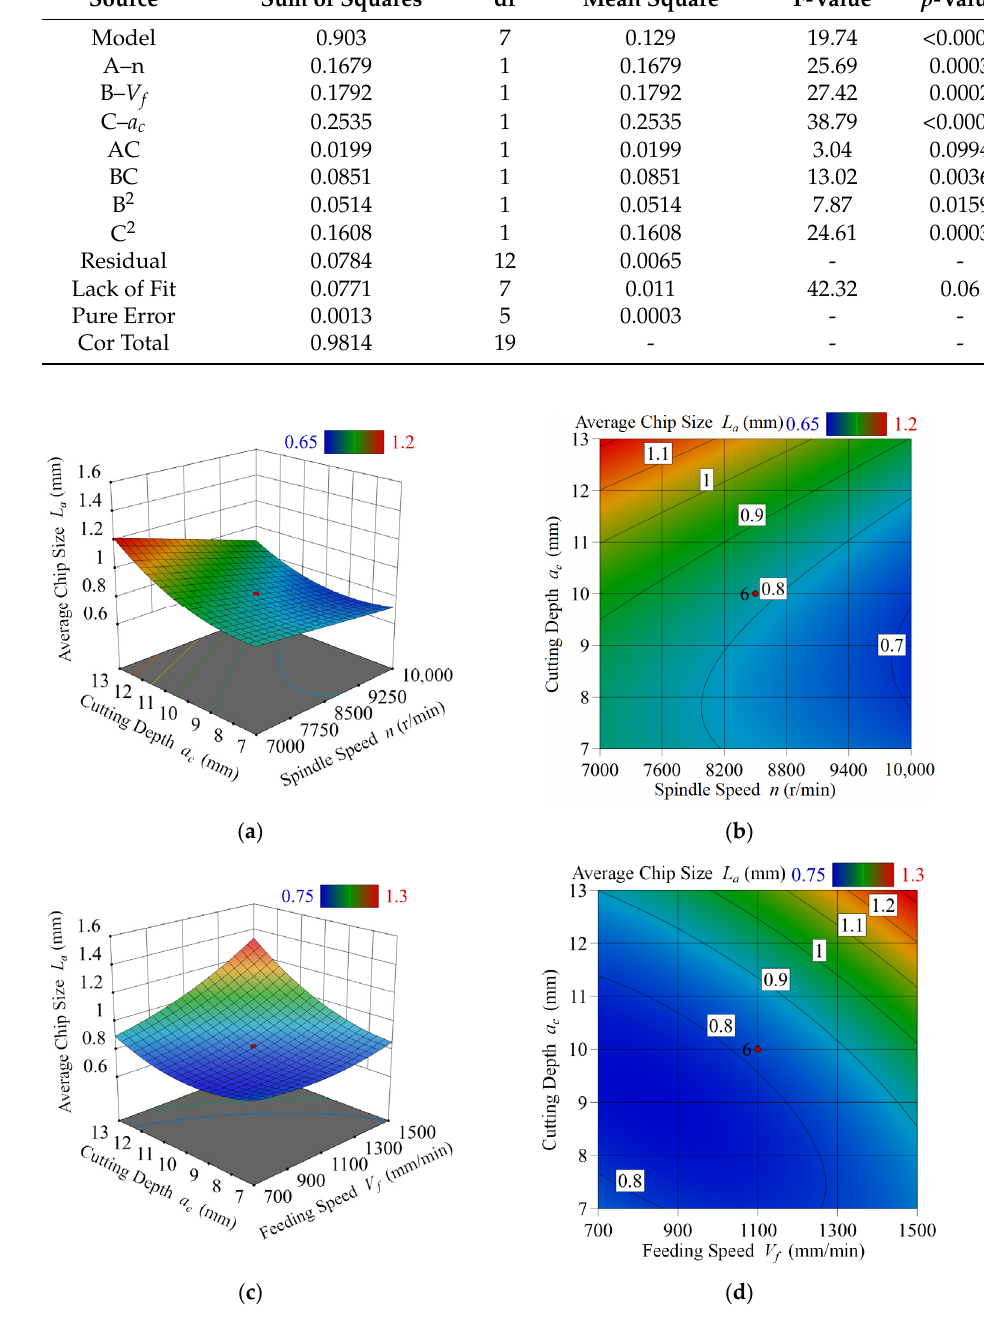
Figure 8. Relationship between the average chip size L a and feed rate V f , spindle speed n , and depth of cut a c . ( a ) Response surface plot of average chip size L a as a function of depth of cut a c and spindle speed n . ( b ) Contour plot of the response surface (a). ( c ) Response surface plot of average chip size L a as a function of depth of cut a c and feed rate V f . ( d ) Contour plot of the response surface (c).